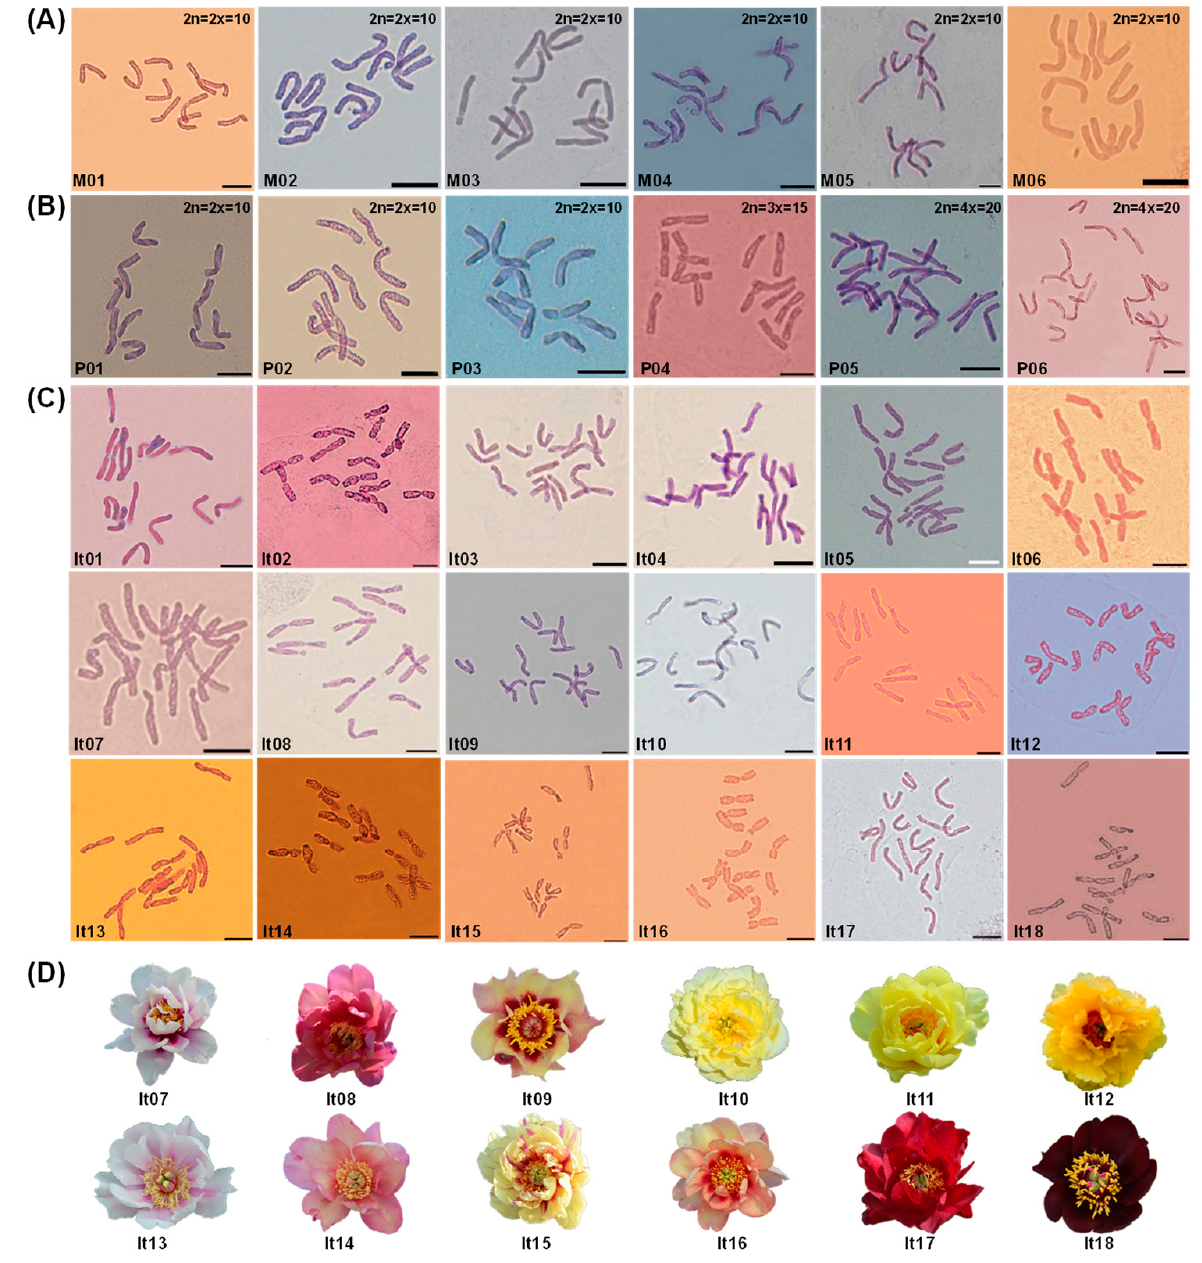
Figure 2. Metaphase chromosomes of 30 peony materials in ( A ) sect. Moutan , ( B ) sect. Paeonia , ( C ) Itoh hybrids, and ( D ) morphology of Itoh hybrids It07–It18. The ploidy of materials in ( A , B ) are shown on the upper right of each image. The codes in ( A – D ) represent the material names as shown in Tables 1 and 2; bar = 10 μ m.